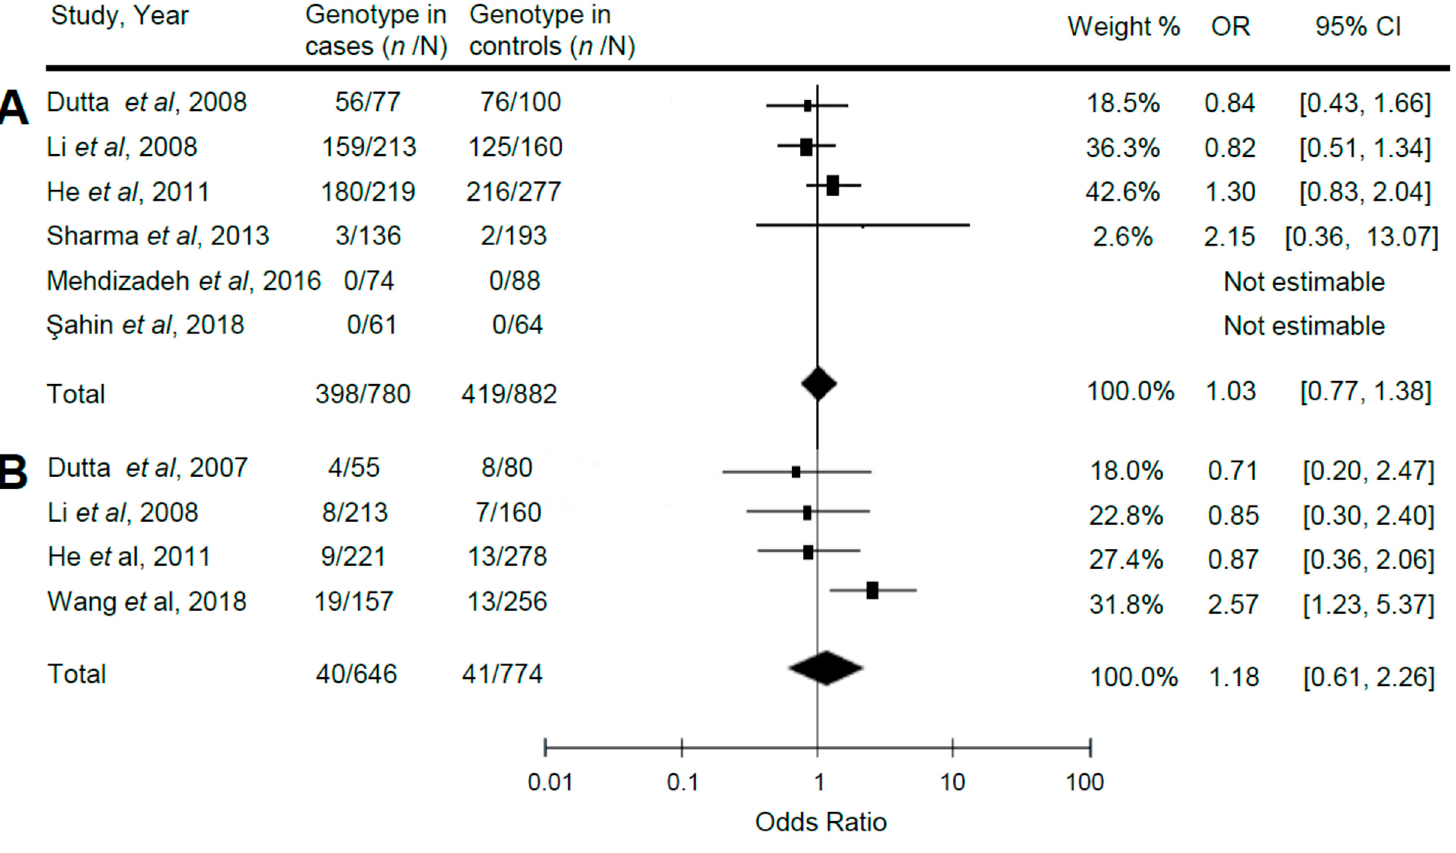
Figure 2. Cont Figure 2. Cont .